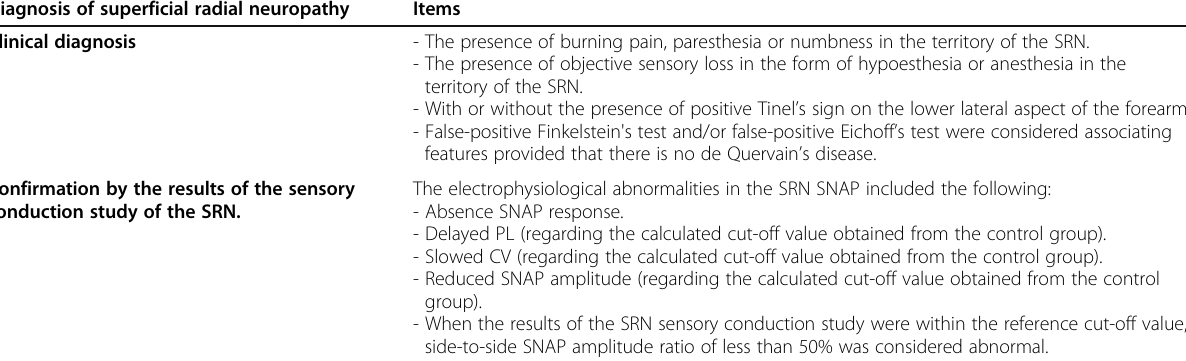
Table 1 Criteria for diagnosing superficial radial neuropathy [2, 4, 9 – 11, 13, 20] Diagnosis of superficial radial neuropathy Items Clinical diagnosis - The presence of burning pain, paresthesia or numbness in the territory of the SRN. - The presence of objective sensory loss in the form of hypoesthesia or anesthesia in the territory of the SRN. - With or without the presence of positive Tinel ’ s sign on the lower lateral aspect of the forearm. - False-positive Finkelstein's test and/or false-positive Eichoff ’ s test were considered associating features provided that there is no de Quervain ’ s disease. Confirmation by the results of the sensory conduction study of the